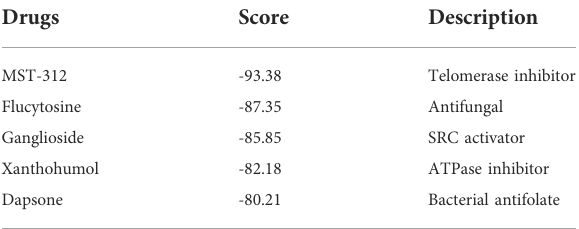
TABLE 1 Summary of connectivity map prediction